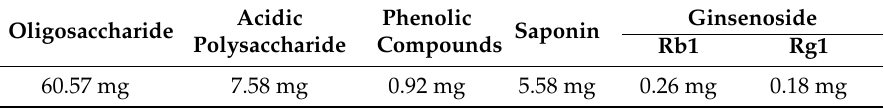
Table 1. Chemical composition of red ginseng (RG). Analyzed extracts from 100 mg Korean red ginseng. Oligosaccharide